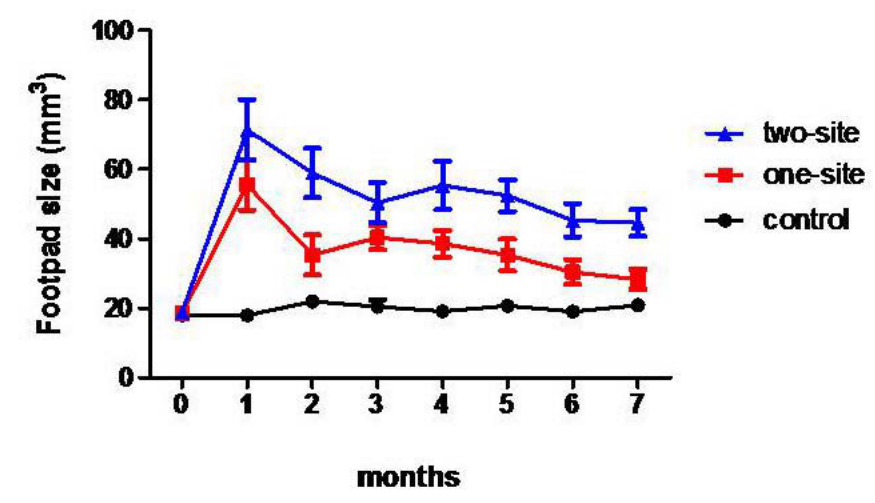
Figure 4. Kinetics of lesions from BALB/c mice that were subcutaneously infected with aged inocula of F. pedrosoi at one (squares, red) and two footpads (triangles, blue). The control group was treated with 50 µL of PBS (circles, black). Footpads of mice were measured every 30 days for seven months after inoculation. Animals infected at two sites had strong swelling and a more chronic infectious process. Data are shown with mean and SE values, ANOVA test, p <